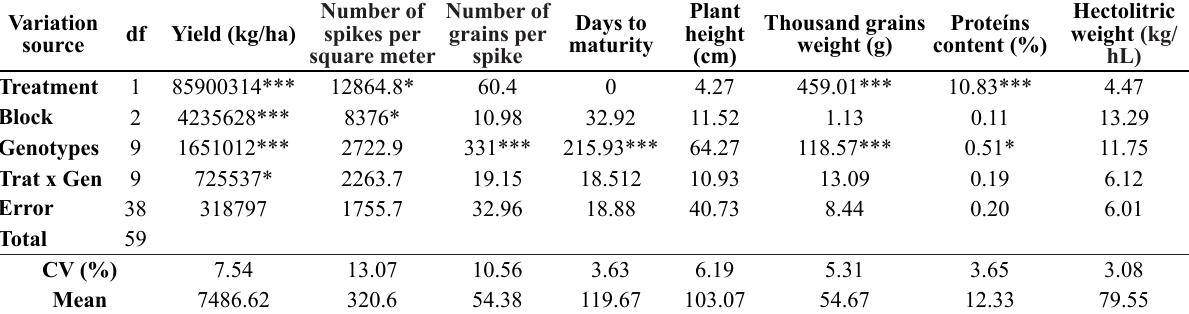
Table 7. Mean squares of the combined analysis of variance of grain yield, number of spikes per square meter, number of grains per spike, thousand grains weight (g), days to maturity, plant height (cm), protein of grains (%) and hectolitric weight (kg/hL) of the control experiment (complete irrigation) and drought treatment (deficit irrigation) of tolerant wheat genotypes ( Triticum aestivum L.) to drought under conditions of La Molina LM 2019B.